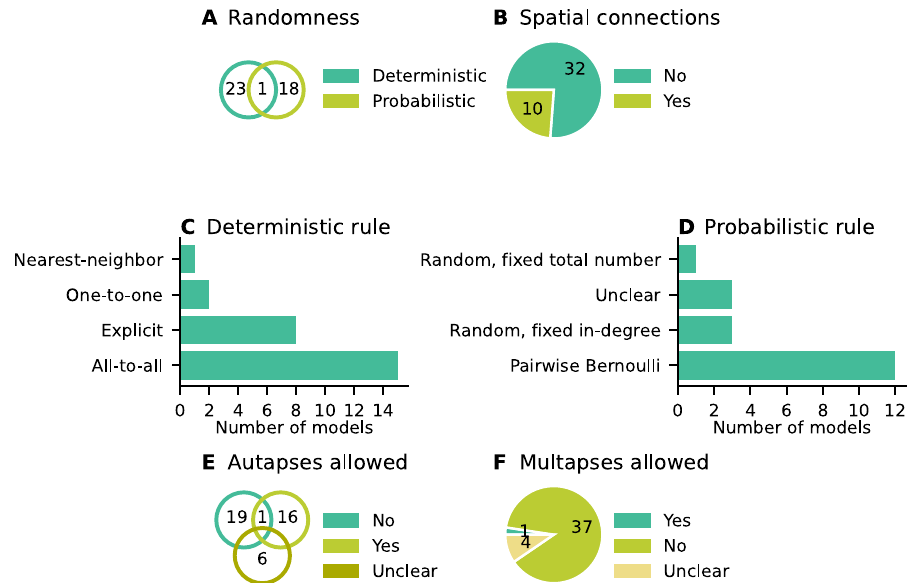
Fig 6. Concepts: Which connectivity concepts are realized? (A) Whether connections in the model are probabilistic or deterministic. (B) Whether at least some part of the model contains distance-dependent connections. (C) Name of deterministic connectivity rule specifying the connectivity in at least a part of the model network (compare Fig 7A and 7B). (D) Name of probabilistic connectivity rule specifying the connectivity in at least a part of the model network (compare Fig 7C–7F). One network model can use multiple deterministic and probabilistic rules or may use none of the given rules; therefore the numbers of models in panels C and D do not add up to the total number of studies. (E) Whether self-connections are allowed (illustrated in Fig 7G). The intersections in panels A, B, and E refer to models which have different properties in different parts of the networks. (F) Whether multiple connections from a source node to a target node are allowed (illustrated in Fig